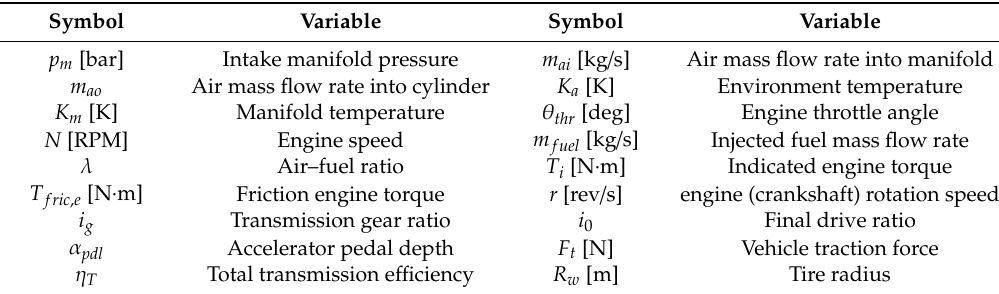
Figure 1. Simplified vehicle powertrain systems. Table 1. Notation used in models.